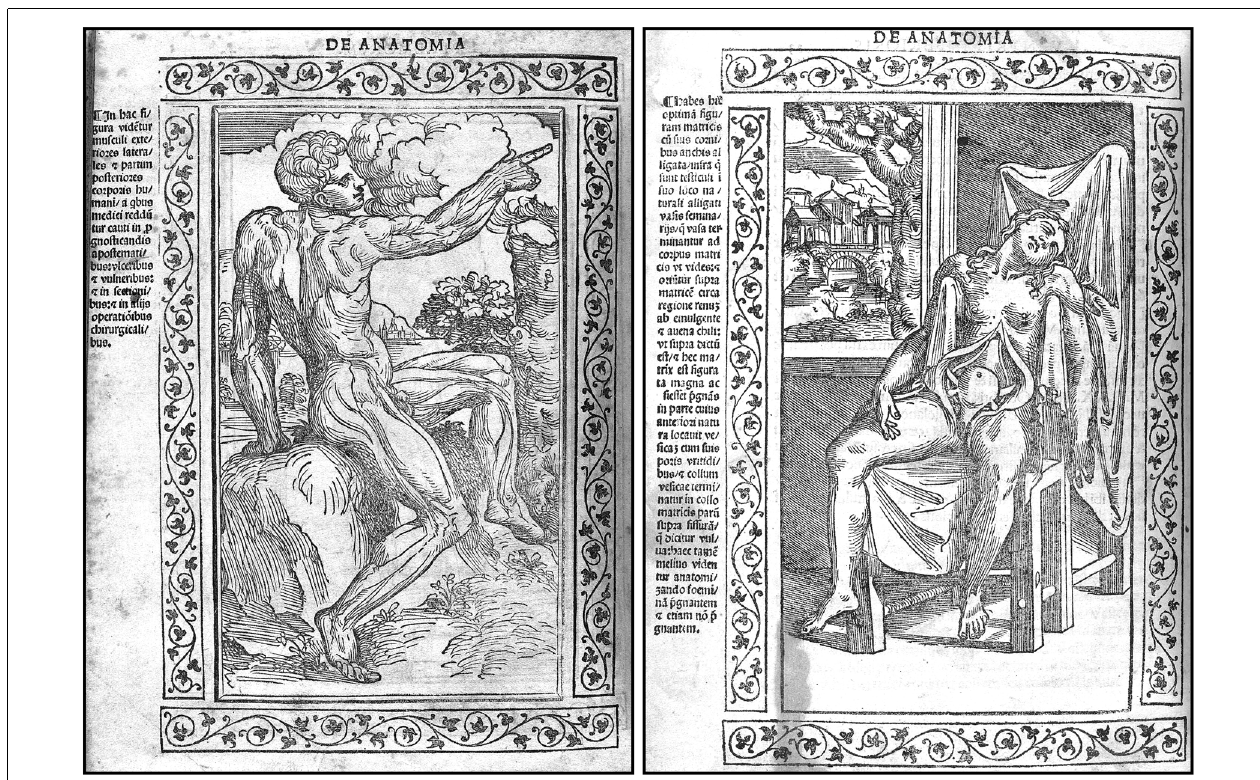
FIGURE 3 | Two woodcuts from the 1523 edition of Berengario’s Isagogae breves . The figure on the left (folio 71v) shows a man standing in nature with his muscular anatomy particularly well outlined, whereas the figure on the right (folio 23v) depicts a woman sitting in a chair with abdominal viscera, particularly the uterus, clearly visible. The drawings are surrounded by floral motifs, and a detailed legend is provided on the left of each figure. These woodcuts might be the work of Hugo da Carpi (1455–1523; Courtesy of the National Library of